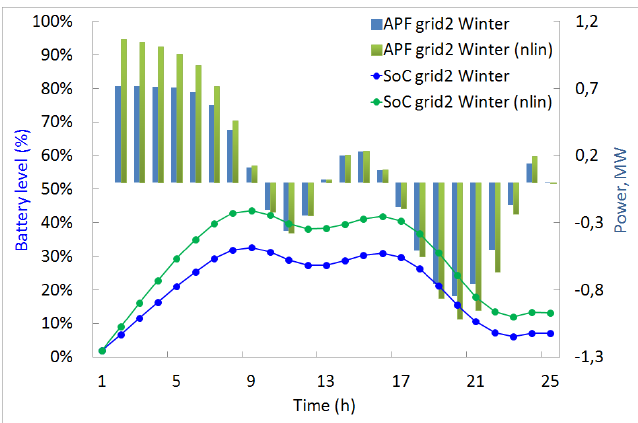
Figure 2. Alternating power functions (APF in MW) with state of charge information (SOC in %) computed by the system of Volterra integral Equation (34) for the winter